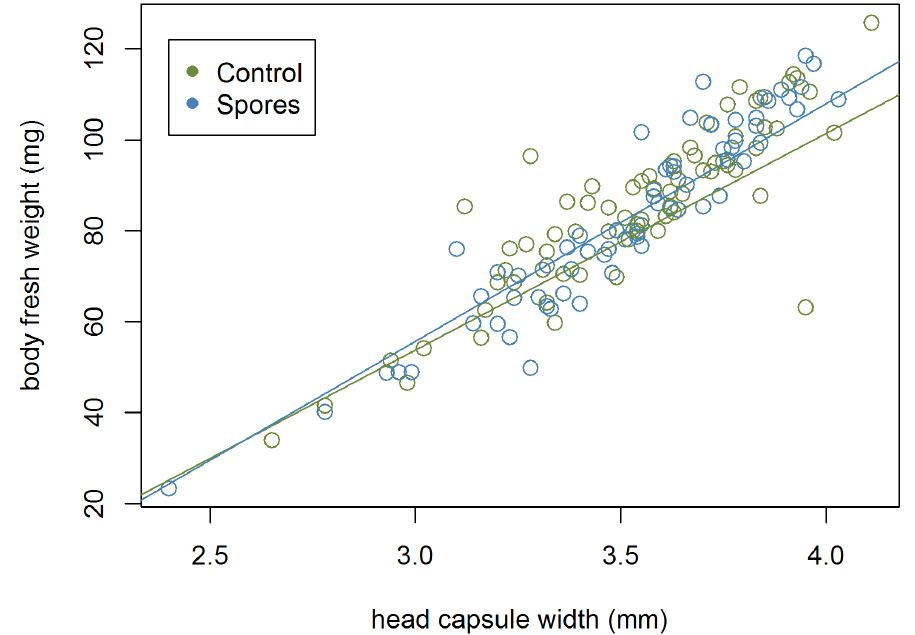
Figure A1. Female head capsule width and fresh body weight (pharate dataset), N = 139.